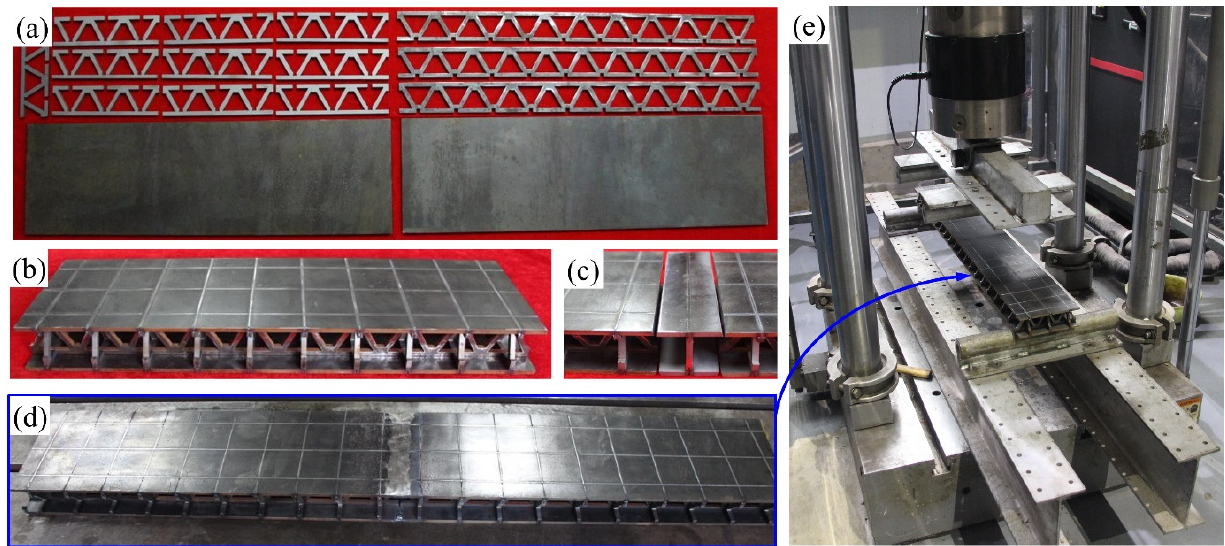
Figure 4. Detailed manufactured samples ( a – d ) and experimental setup ( e ).